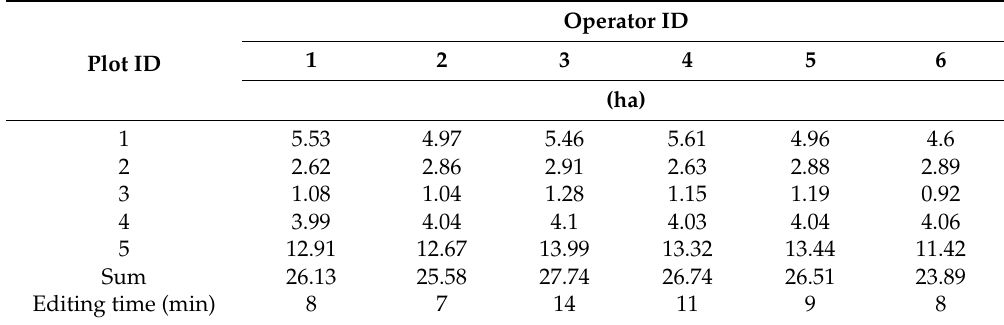
Table 4. Comparison of edited windthrow areas and editing time of operators when using the UAS/ALS